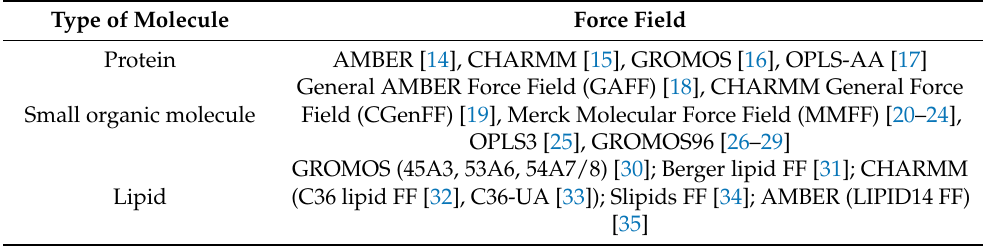
Table 1. Examples of commonly used force fields in molecular dynamics